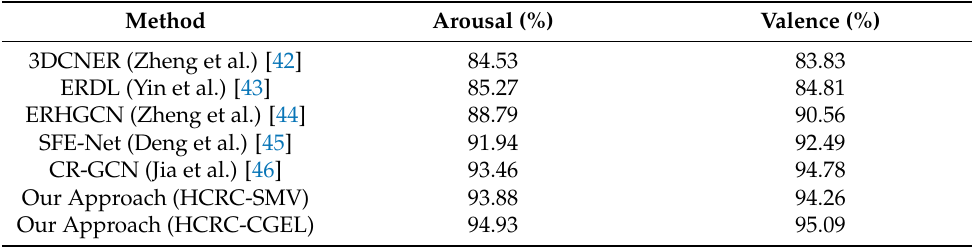
Table 3. Mean accuracy in arousal and valence of DEAP database.